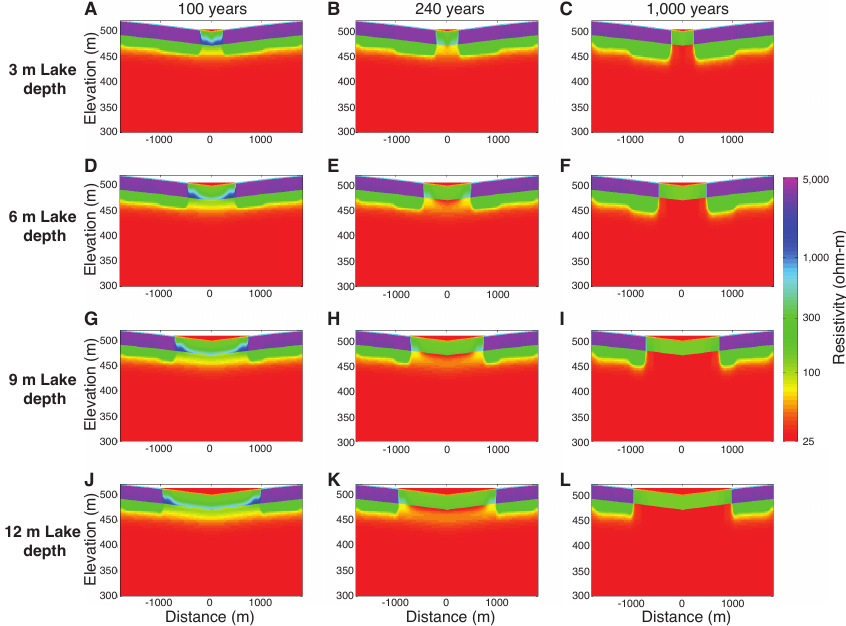
Figure 4. Synthetic bulk resistivity images under hydrostatic flow and current climate conditions. Lake depths of 3m (a–c) , 6m (d–f) , 9m (g–i) , and 12m (j–l) are illustrated at simulation times 100, 240, and 1000 years.